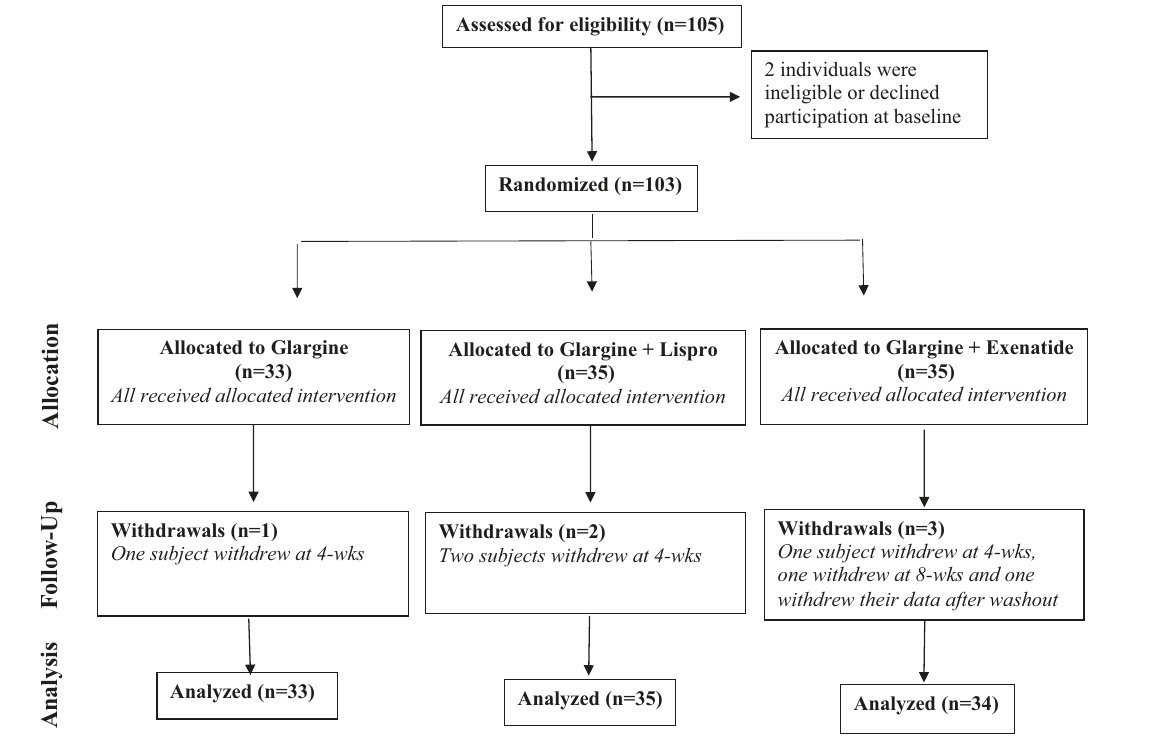
Fig. 2 | CONSORT (Consolidated Standards of Reporting Trials) pro fi le showing fl ow of trial